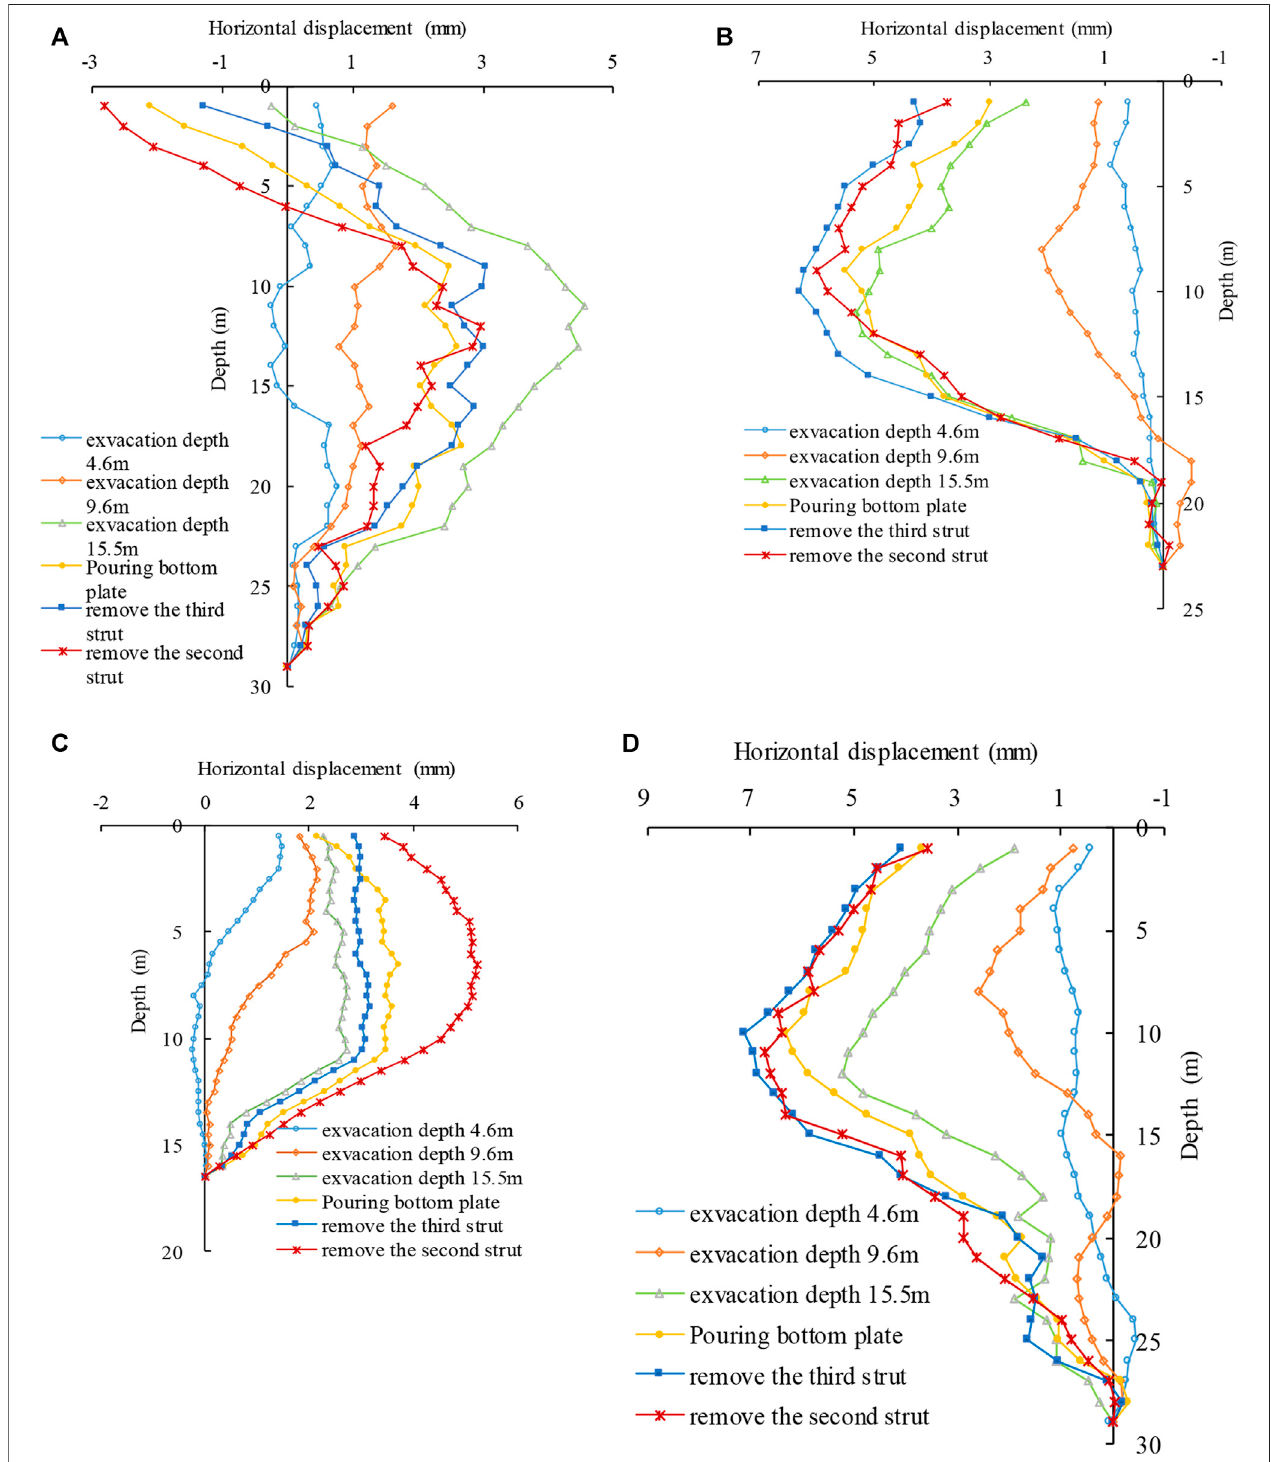
FIGURE 9 | Horizontal deformation of retaining structure: (A) SS02, (B) SS15, (C) SS01, and (D) SS16.